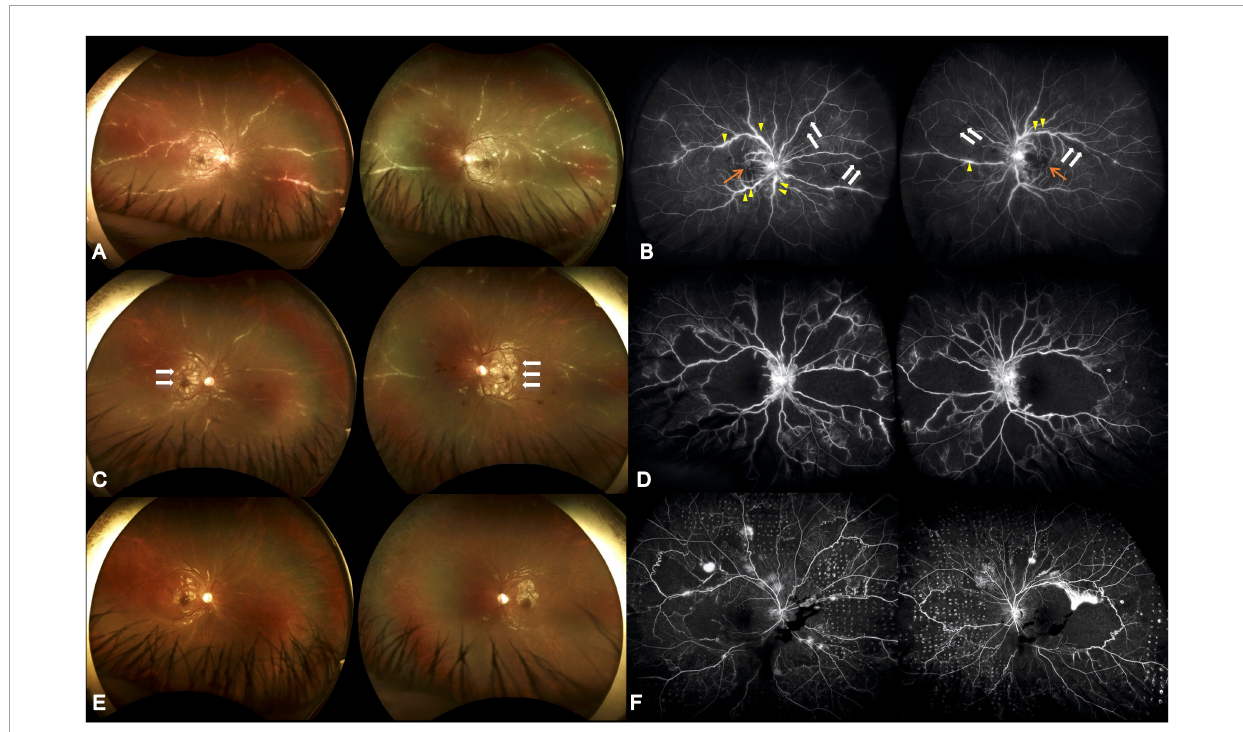
FIGURE1 Serial ultrawide-field fundus photographs. (A) Initial presentation showed diffuse perivascular sheathing with frosted branch angiitis appearance. (B) Initial fluorescein angiography revealed multiple segmental phlebitis (yellow arrow) with occlusive arteritis (white arrow) and retinal non-perfusion (orange arrow). The visual acuity was 0.025 (both eyes). (C) Four weeks later, partial resolution of the perivasculitis following systemic corticosteroid and antiviral treatment was seen; however, aggravated Purtscher-like retinopathy was demonstrated (white arrow). (D) Twenty-one weeks after initial visit and 8 weeks following HBOT, alleviated vascular leakage, however, with extensive macular and midperipheral retinal non-perfusion was shown. The visual acuity was 0.16 (both eyes). (E) Nineteen weeks after initial visit, reduced Purtscher fleckens was note. Frosted branch angiitis almost completely resolved following combined corticosteroid, antiviral agent, and immunosuppressive medications. (F) Thirty-nine weeks after initial visit and 26 weeks following HBOT as well as 15 weeks after retinal photocoagulation, there were vascular leakage with few vitreous hemorrhage. The visual acuity was 0.1 (right) and 0.16 (left).